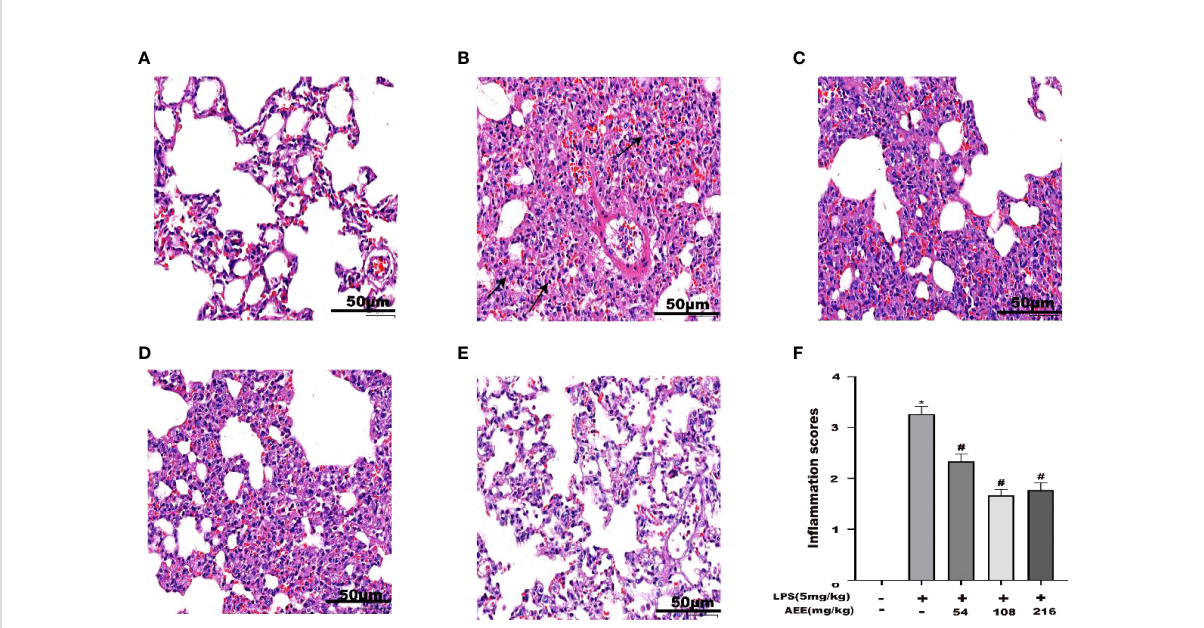
FIGURE 8 Effect of AEE on histopathological changes in the lungs of LPS-induced ALI rats. (A) Control group, (B) LPS group, (C) LPS + AEE group (AEE, 54 mg kg -1 ), (D) LPS + AEE group (AEE, 108 mg kg -1 ), (E) LPS + AEE group (AEE, 216 mg kg -1 ), (F) In fl ammatory change score chart. * P < 0.05 compared to control group, # P < 0.05 compared to LPS